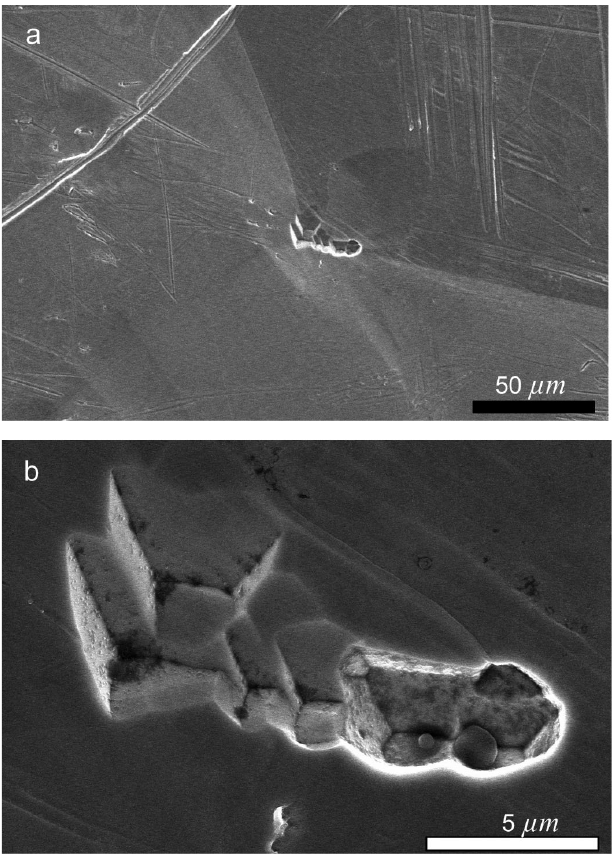
FIG. 6. SEM image showing the tricrystal etch pit of sample No. 7 (a). A higher resolution image of the pit is shown in (b). The profile of the pit is shallower than the ones shown in Figs. 7 and 8.